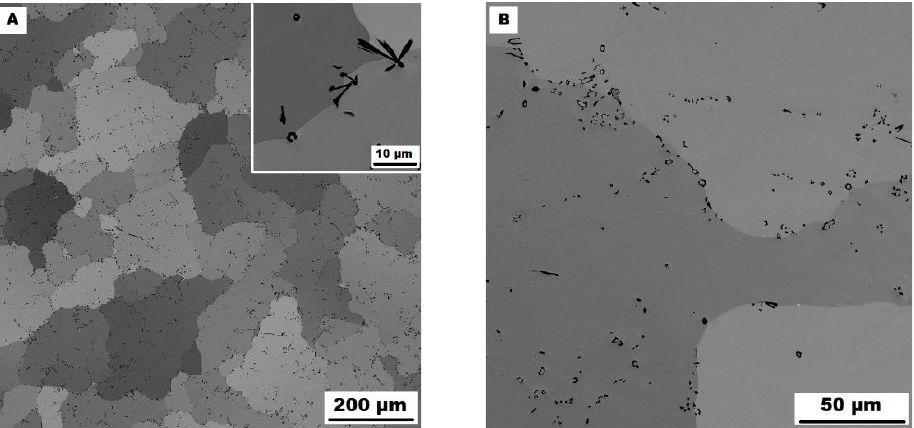
Figure 10. The structure of Fe–28Al–5Si–2Ti–1B HT 800/100 alloy (SEM, 10 kV, BSE). ( A ) overview of the structure, ( B ) detail of the structure.